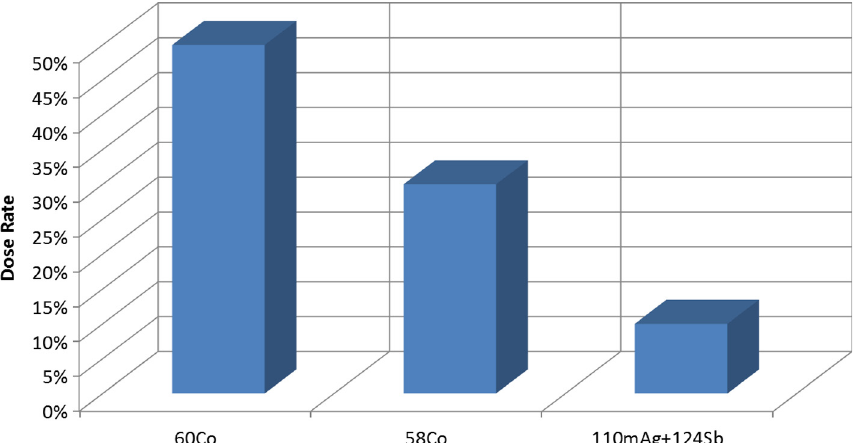
Fig. 1. Main contributors to doses coming from surface contamination by activated corrosion products [4].